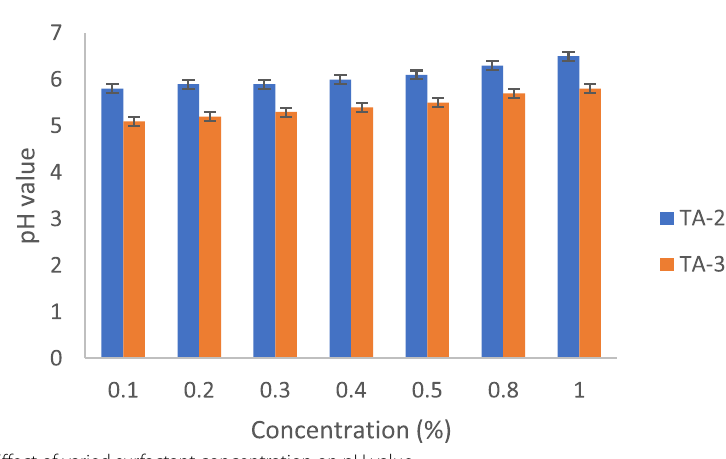
Fig. 5 Effect of varied surfactant concentration on pH